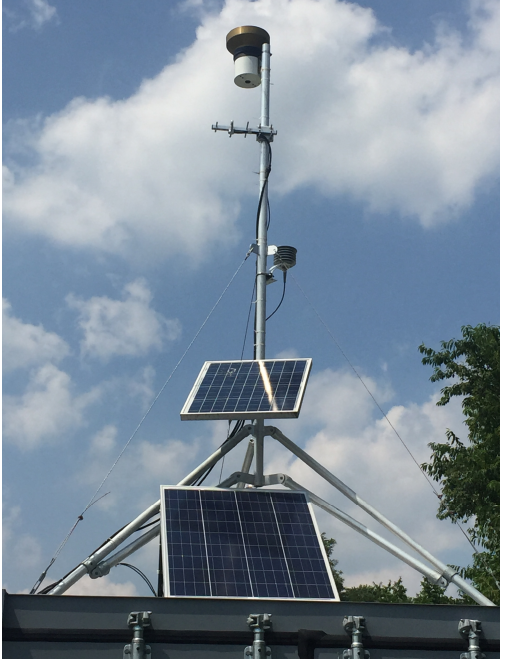
Figure 7. Weather station with 3 dB Yagi antenna for data transmission from the